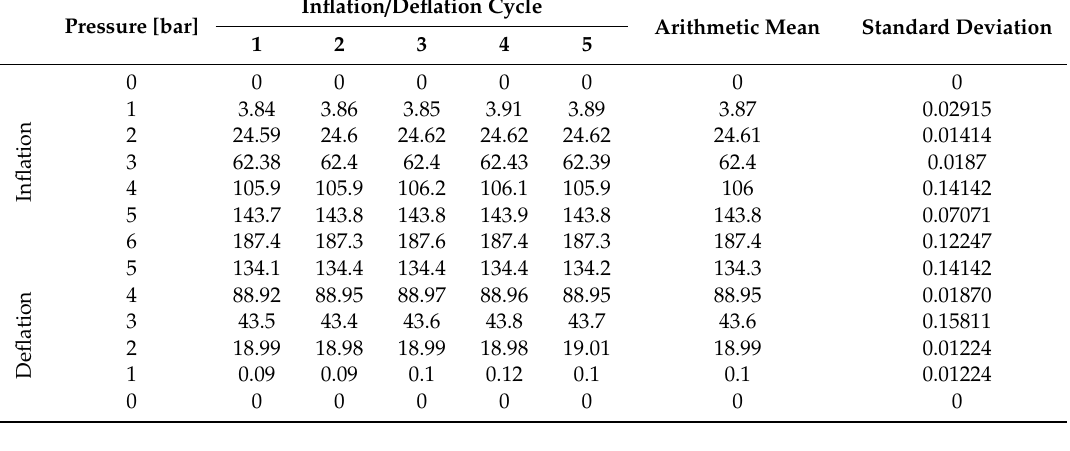
Table 4. Correspondence between the developed force and the charging pressure.